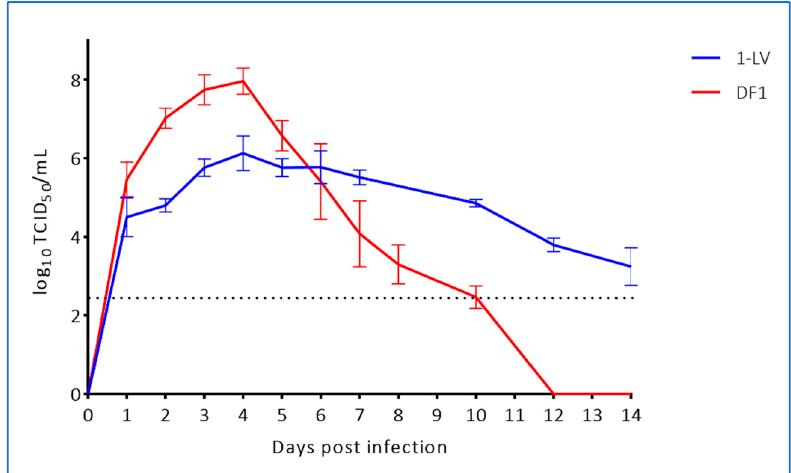
Figure 4. Comparison of WNV KUN replication in crocodile cells (1-LV) versus avian cells (DF-1) during a two-week period. Cells were infected at a MOI = 1 and triplicate wells were terminated at the indicated time points and tested individually for viable virus by TCID 50 -assay in C6/36 mosquito cells. Stippled line indicates limit of detection.